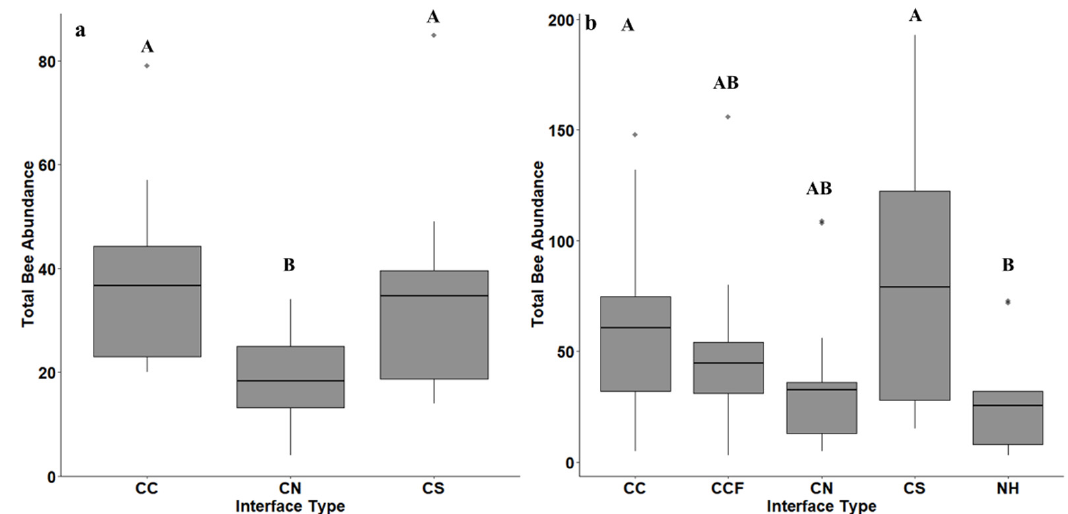
Figure 4. The average abundance of all native bees across across crop and semi-natural interfaces taken from bee-bowl collection conducted in 2017 ( a ) and 2018 ( b ) shown as boxplots. The interface types were sites between a cotton field and another cotton field (CC), a sorghum field (CS), semi-natural habitat (CN), another cotton field 1 km away from semi-natural habitat (CCF) and semi-natural habitat alone (NH). The solid black bar gives treatment mean, boxes give the 1st and 3rd quartiles, and diamonds show outliers. Abundances across interface types were compared using Tukey’s HSD means procedure with letters differing across means indicating significant differences.